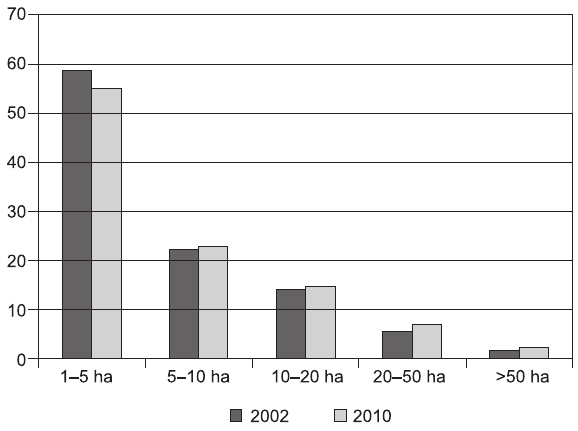
Fig. 4. Changes in the share of farms (of more than 1 ha) in the particular size groups in Poland in 2002 and 2010 (%) Source: authors’ own calculation based on 2011 data from rural areas in Poland and 2002 and 2010 Agricultural